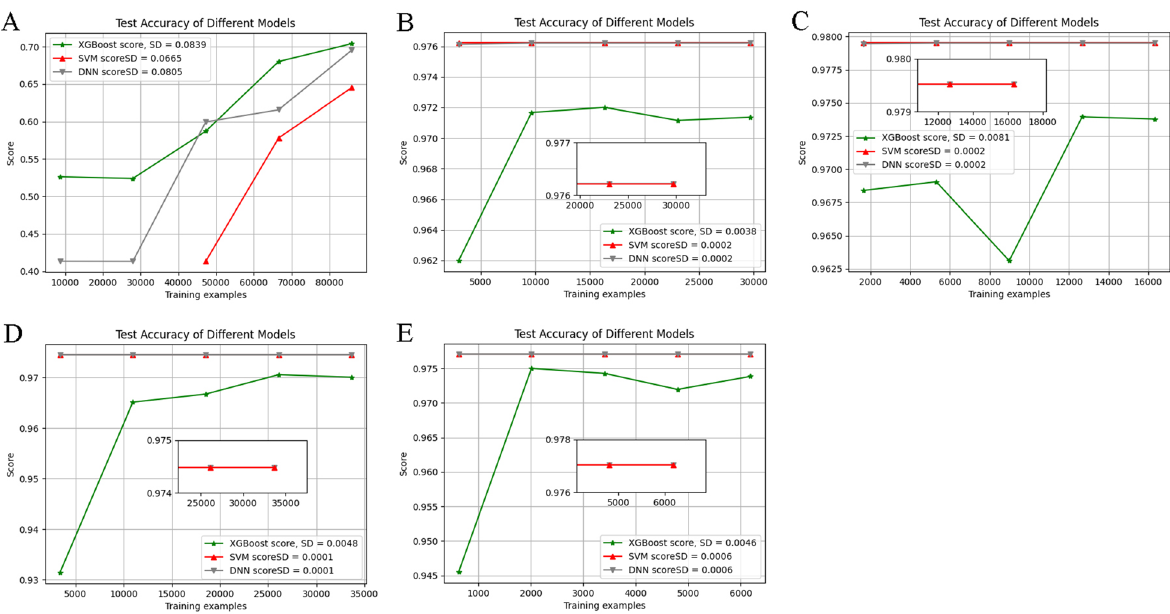
Figure 3. Test accuracy of different models for blood donor recruitment. The three top/median performing algorithms (XGBoost, SVM, and DNN) validated in the training-test dataset were trained and evaluated by tenfold cross-validation method in different datasets. The highest accuracy scores were achieved by XGBoost in the full ABO dataset, and by SVM in the four individual blood group datasets. ( A ) The accuracy was calculated by XGBoost, SVM, and DNN algorithms respectively in the full ABO dataset. ( B ) The accuracy was calculated by XGBoost, SVM, and DNN algorithms respectively in the A blood group dataset. ( C ) The accuracy was calculated by XGBoost, SVM, and DNN algorithms respectively in the B blood group dataset. ( D ) The accuracy was calculated by XGBoost, SVM, and DNN algorithms respectively in the O blood group dataset. ( E ) The accuracy was calculated by XGBoost, SVM, and DNN algorithms respectively in the AB blood group